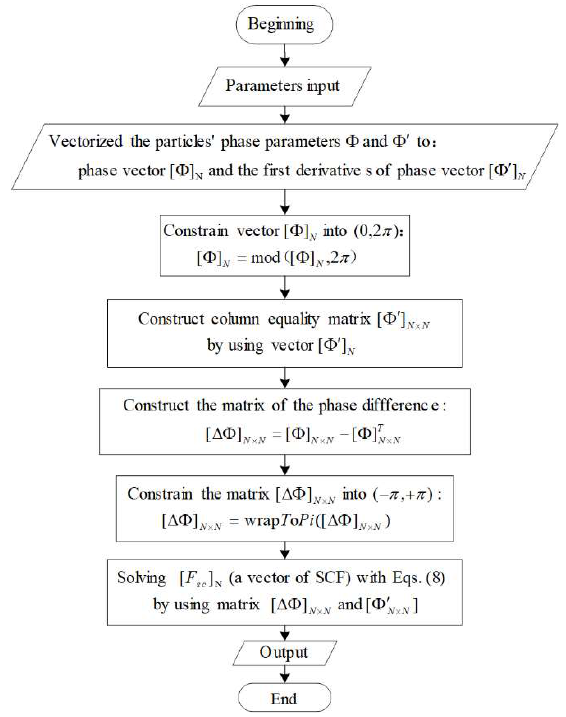
Figure 9. The schematic diagram of the GPU-parallelized algorithm.